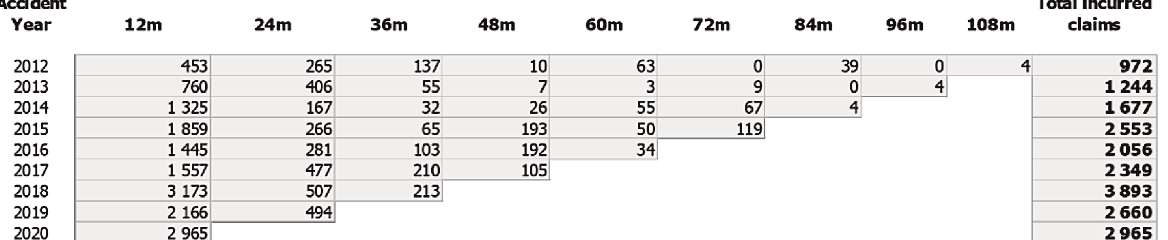
Fig. 4. An example of data set during data collection in thousands EUR.